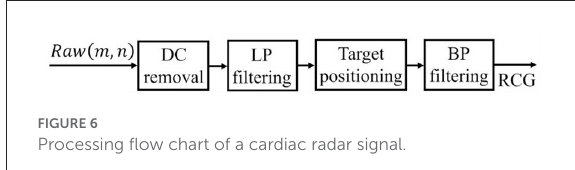
FIGURE6 Processing flow chart of a cardiac radar